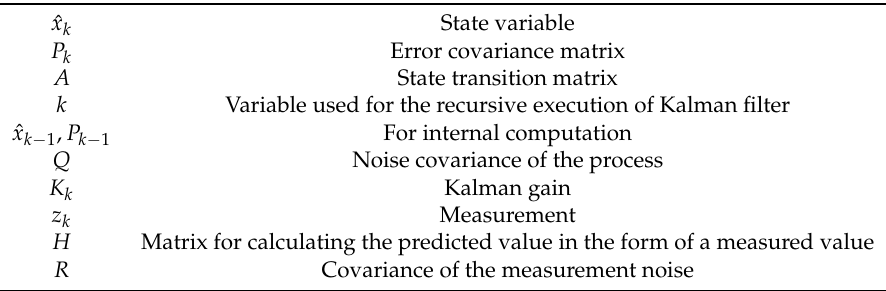
Table 1. Variables used in the LKF